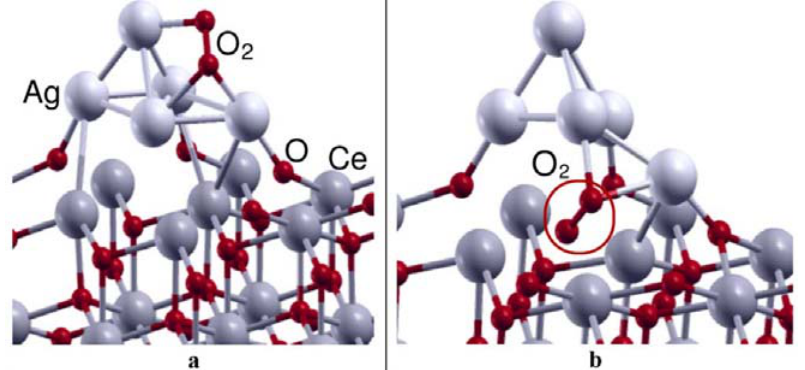
Figure 16. Structure of O 2 adsorbed on Ag 5 /CeO 2 − x (111) surface complex. ( a ) Isomer where O 2 is above the Ag cluster and forms a superoxo species (less stable); ( b ) isomer where O 2 is below the Ag cluster and forms a peroxo group (more stable). Reproduced from Ref. [152]. Copyright© 2011, Elsevier.